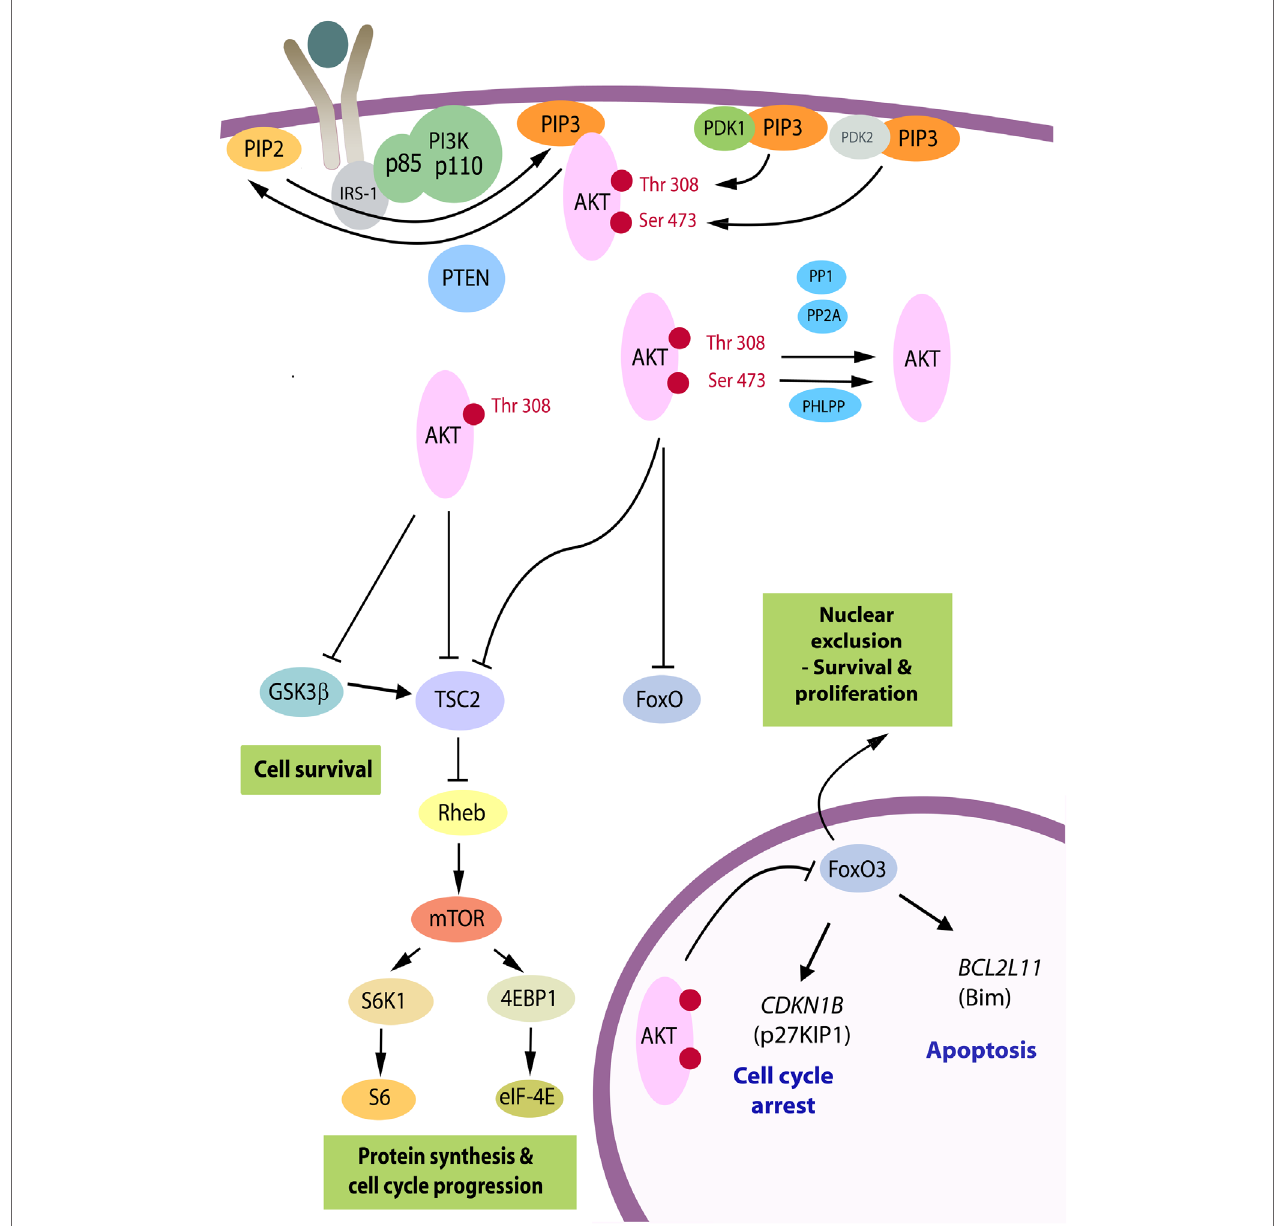
FiGURe 1 | The Pi3K/Akt pathway . Akt is recruited to the plasma membrane by phosphatidylinositol (3,4,5) trisphosphate (PIP3) produced from phosphatidylinositol (4, 5) bisphosphate (PIP2) by phosphatidylinositol 3-kinase (PI3K). PTEN is a phosphatase that promotes the reverse reaction. For activation, Akt is phosphorylated on Thr(308) by phosphoinositide-dependent kinase 1 (PDK1) and on Ser(473) primarily by the mTORC2 complex serving as PDK2. Upon full activation, Akt leaves the membrane and can adopt a nuclear or cytosolic localization. There are over 70 known molecular targets of the Akt kinase and the three targets believed to be the most important in carcinogenesis are shown. By phosphorylation of TSC2, Akt relieves its repressive effects on Rheb, resulting in downstream activation of the mTORC1 complex and enhanced RNA translation. GSK3 β is a tumor suppressor, which targets a number of proliferation and survival regulators, including β -catenin and Mcl-1, and elevates activity of TSC2 [reviewed in Ref. (9)]. The family of forkhead transcription factors, FoxO, upregulates genes controlling cell cycle arrest and apoptosis and is inhibited by Akt. Whereas GSK3 β and TSC2 can be phosphorylated by p-Akt(Thr308) in cells, phosphorylation at Ser(473) is critical to inactivate FoxO proteins [reviewed in Ref. (8)]. When these are phosphorylated they become transcriptionally inactive and subject to nuclear export. FoxO3A exhibits reduced nuclear expression in the majority of thyroid cancers in association with high levels of p-Akt(Ser473), and relevant FoxO3A downstream target genes have been identified in follicular rat thyroid cells (10) and subsequently in benign (FRTL-5) and malignant human thyrocytes (FTC-133) (11), as the CDKN1B gene encoding cyclin-dependent kinase inhibitor, p27 KIP1 , and BCL2L11 , encoding Bim, a pro-apoptotic member of the Bcl-2 family of